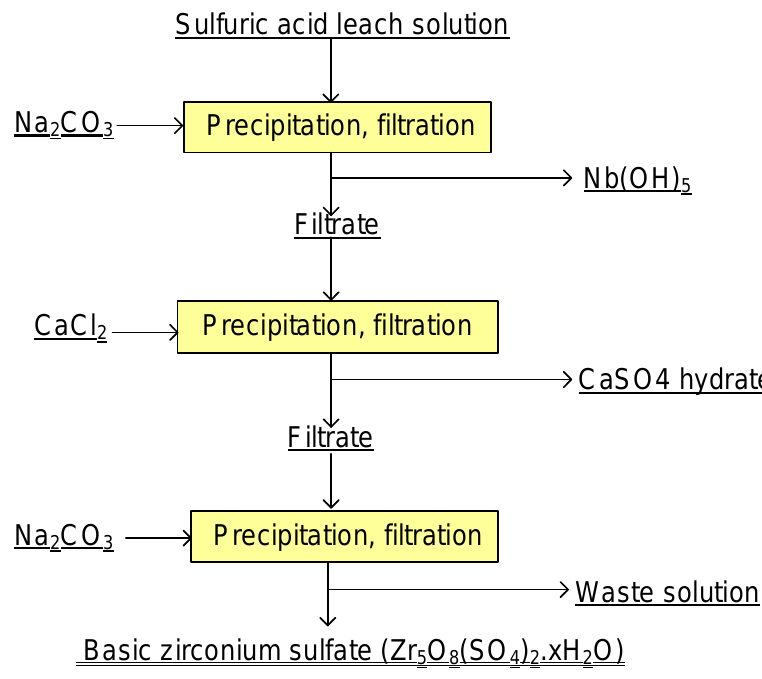
Figure 3. Proposed flowchart for recovery of Zr using precipitation methods.